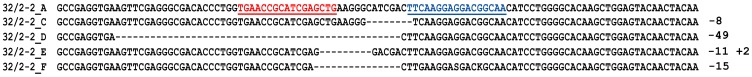
Various gfp alleles (A–F) present in T1 individuals derived from the primary transformant 32/2-2.The underlined sequence in red represents the left and that in blue the right TALEN binding site. Note that allele 32/2-2_B (not shown in this figure) that was identified in the primary mutant could not be detected in the progeny.